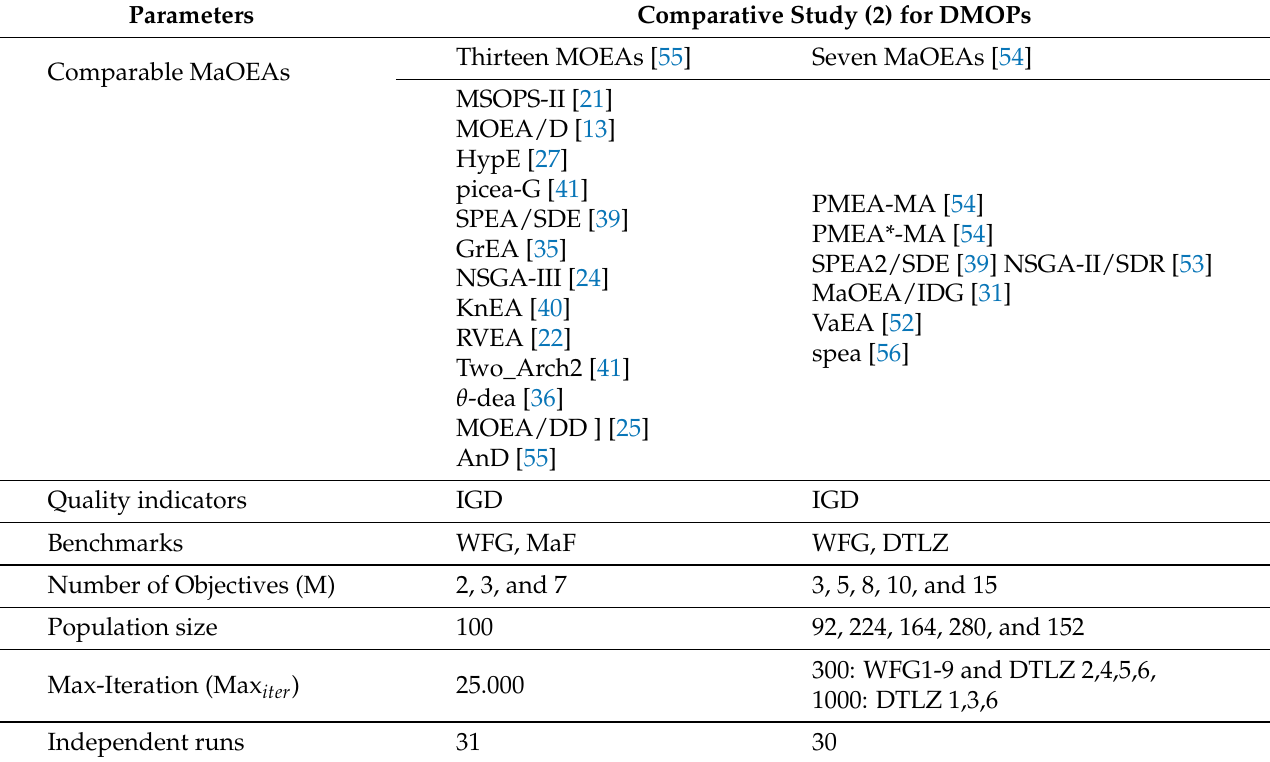
Table 4. Parameters Settings and MaOEAs Solvers used for the comparative study